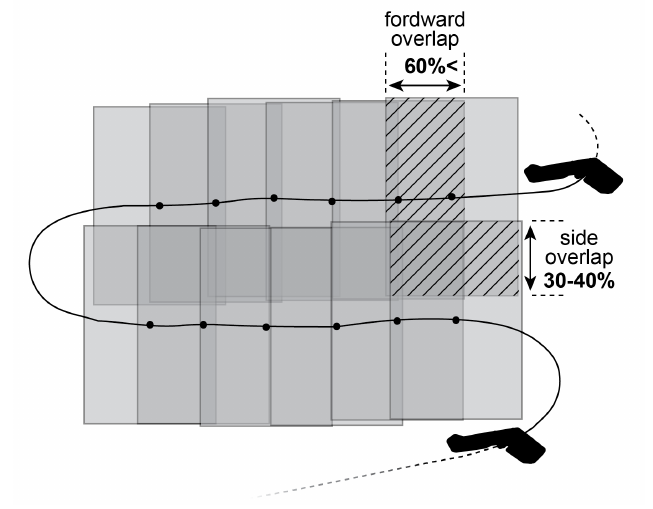
Figure 11. Schematic overview of a photogrammetric flight with minimum overlap